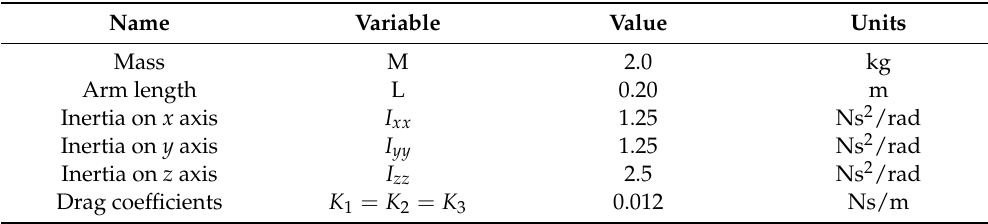
Table 1. Quadrotor model parameters.